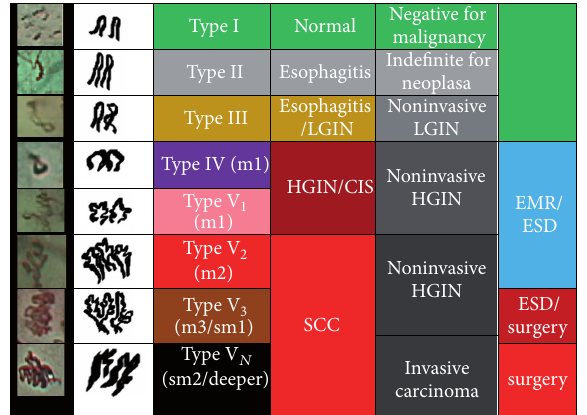
Figure 5: Inoue’s classification of intraepithelial papillary capillary loops for esophageal